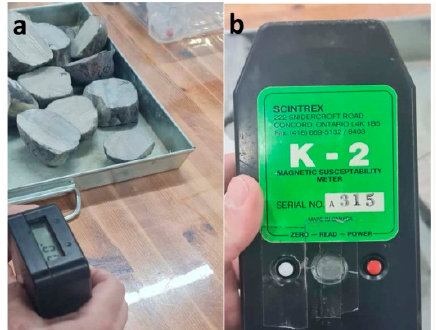
Figure 13. ( a ) The measurement of magnetic susceptibility; ( b ) The Scintrex instrument for magnetic susceptibility study.